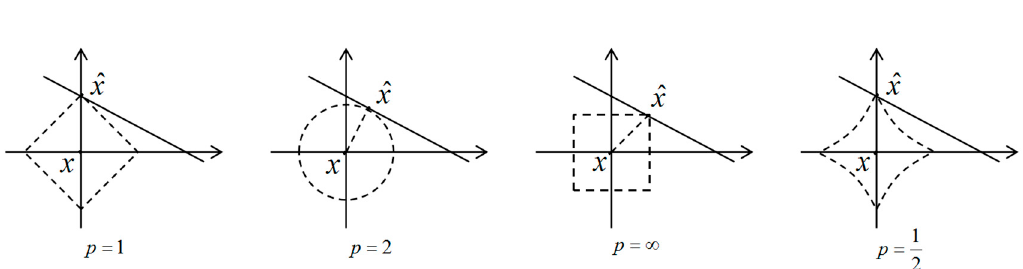
Figure 1. Best approximation of a point in R 2 by a one-dimensional space using the L P norms for P = 1, 2, ∞ , and the L P quasinorm with p = 1 2